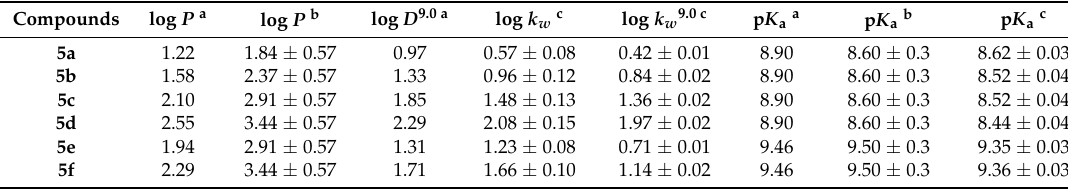
Table 3. Experimentally determined and calculated values of lipophilicity indexes (log k w ) in comparison with software-calculated values of distribution coefficients (log D 9.0 ) and lipophilicity (log P ) of tertiary amines. Experimentally determined p K a in comparison with calculated values of tertiary amines.